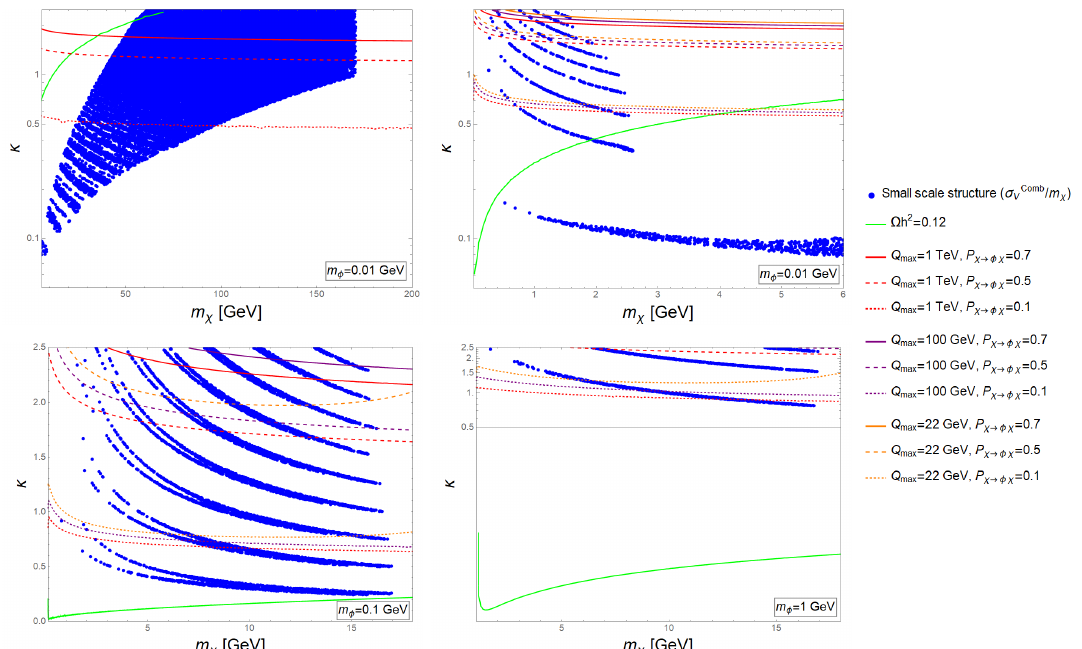
Figure 2 . Dots represent the region, where the small scale structure problem can be addressed, according to analytic formulas σ Comb /m χ (blue). The green lines correspond to the parameters V that give the correct relic density. The red, purple and orange contours indicate the splitting probabilities of χ → φχ for initial χ energies ( Q ) 1 TeV, 100 GeV and 22 GeV, respectively. max More details for the splitting will be discussed in section 4. Three different masses of the scalar mediator are